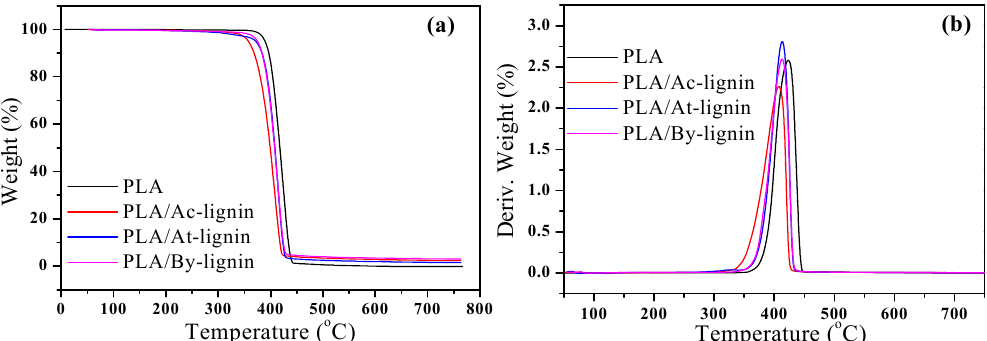
Figure 14. TGA ( a ) and derivative thermogravimetry (DTG) ( b ) curves of PLA and PLA/lignin biocomposites. Table 3. Characteristic thermal degradation temperatures ( T max ) and wt % of char residues from TGA curves.